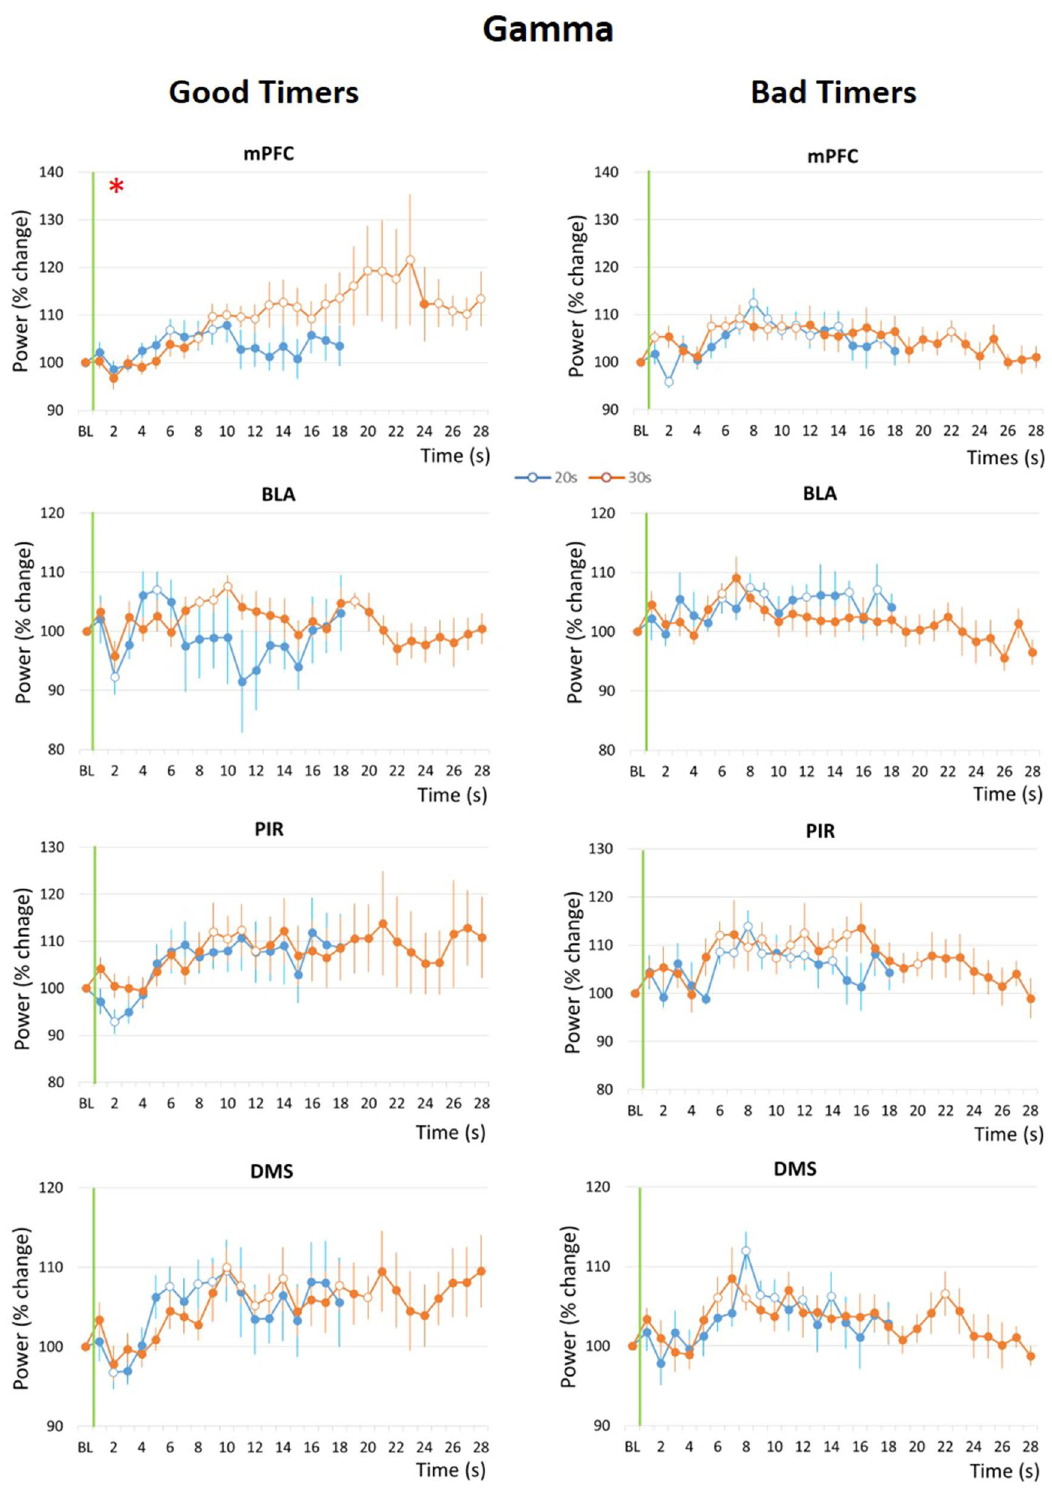
Figure 5. Gamma (40–80 Hz) band mean power variations during the odor-shock interval in the Good Timers (left side) and Bad Timers (right side) subgroups in the four recording sites. mPFC medial prefrontal cortex, BLA basolateral amygdala, PIR olfactory piriform cortex, DMS dorso-medial striatum. For each graph, theta power was expressed as percent change from the baseline (BL), from the odor onset (green vertical line) to shock arrival which occurs either at 20 s (Conditioning session, in blue) or at 30 s (Shift session, in orange). The red asterisk in the upper left corner of a graph signals a significant time × interval duration interaction. Open circles on each curve signal the values that are significantly different from the baseline (p ≤